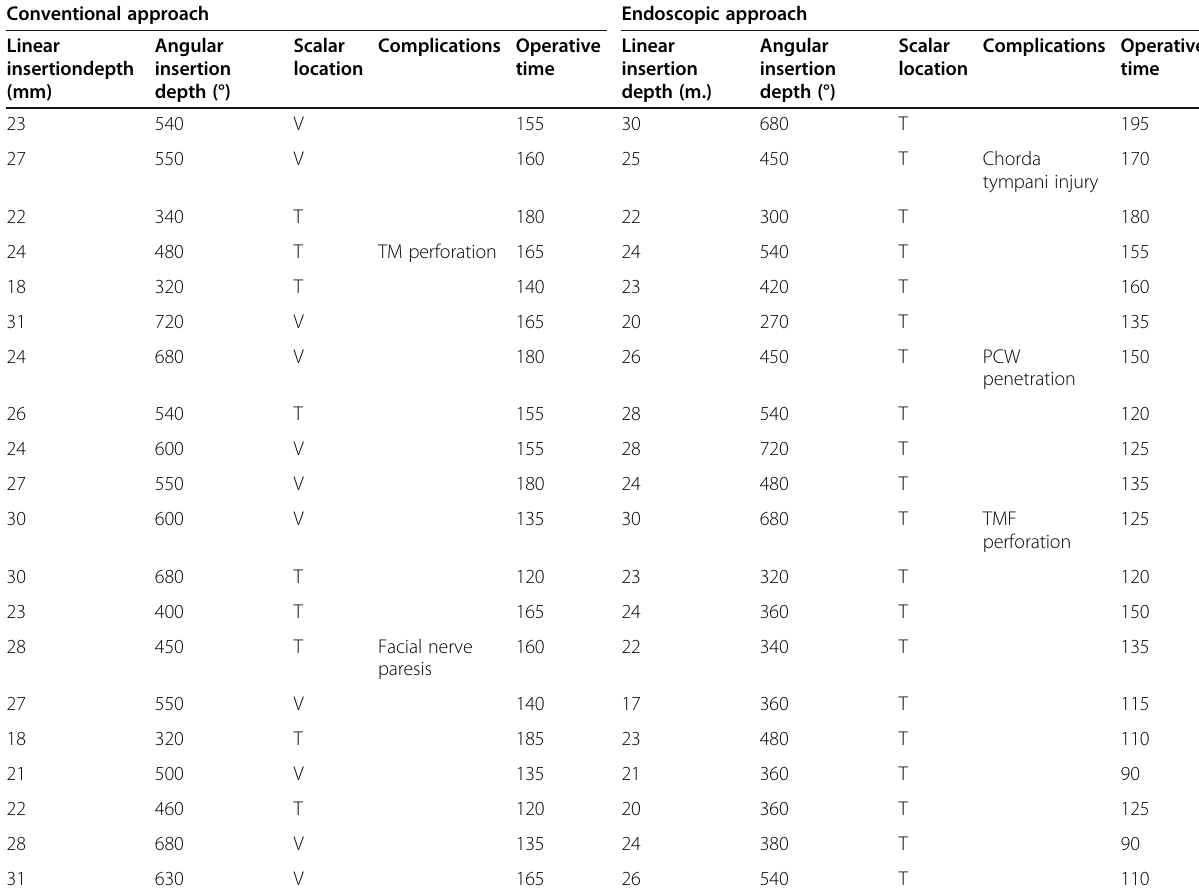
Table 1 A comparison between the two studied groups according to scalar location, insertion depth, complications, and operative time Conventional